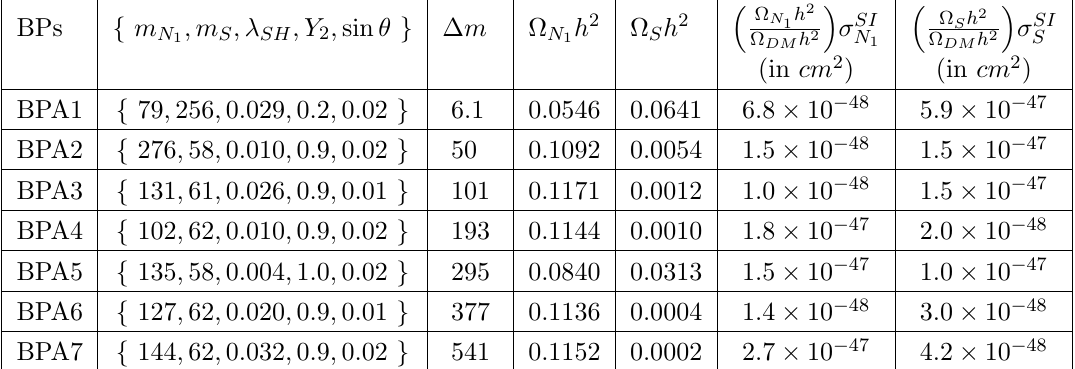
Table 2 . Some benchmark points allowed by relic density, direct search and invisible Higgs and Z decay limit for mediator mass, m (cid:31) = 500 GeV. DM masses, couplings, relic density of individual 2 components and e(cid:11)ective SI direct search cross-sections are mentioned. All the masses are in GeVs. We mainly focus on m N > m S excepting for 1